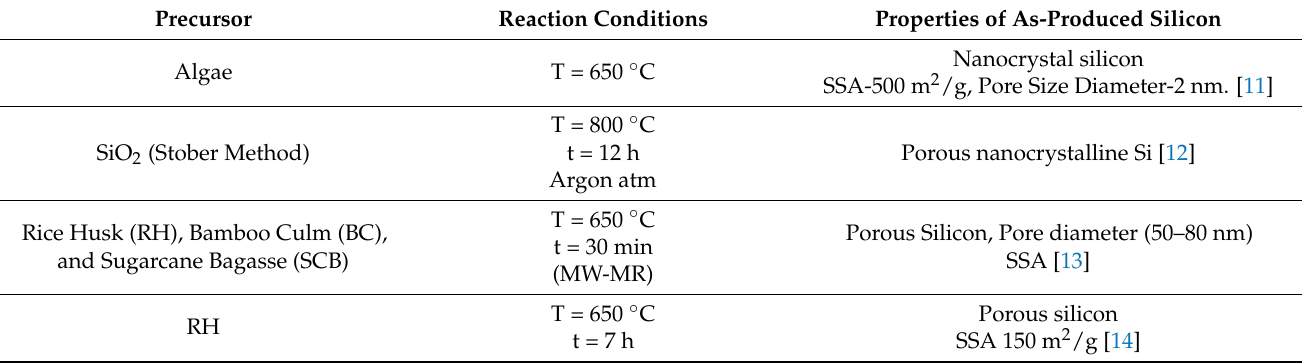
Table 1. Recent studies reporting the magnesiothermic reduction with their results. Precursor Reaction Conditions Properties of As-Produced